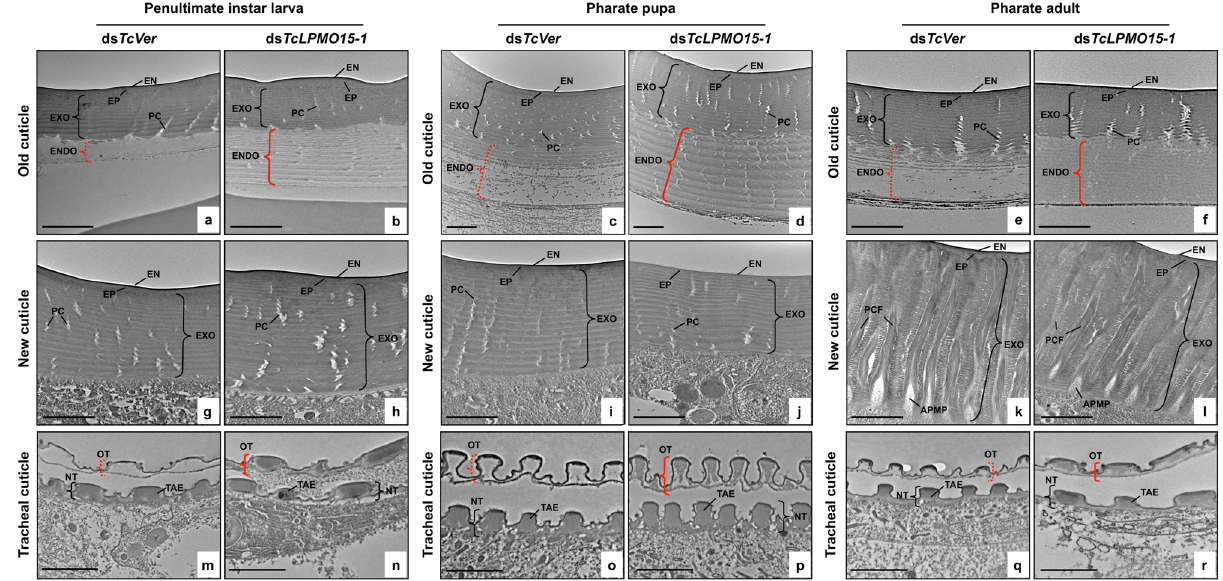
Fig. 5 Ultrastructure of cuticles from Tc LPMO15-1-de fi cient larvae, pharate pupae, and pharate adults of T. castaneum . Ultrastructure of old ( a – f ), newly forming cuticles ( g – l ), and tracheal cuticle ( m – r ) from penultimate instar larvae, pharate pupae, and pharate adults that had been injected with ds TcLPMO15-1 or ds TcVer at early instar, penultimate, and last instar larval stages, respectively, was analyzed by TEM. ds TcVer -treated controls showed degradation of the endocuticle (ENDO) in the overlying old cuticle (red dotted brackets) during each molt analyzed, while those of Tc LPMO15-1-de fi cient insects were intact, retaining a number of chitinous horizontal laminae (red solid brackets). Similarly, ds TcVer -treated controls exhibited degradation of the old tracheal cuticle (red dotted brackets), while the old tracheal cuticle of Tc LPMO15-1-de fi cient insects was incompletely degraded and contained electron-dense materials (red solid brackets). EN, envelope; EP, epicuticle; EXO, exocuticle; ENDO, endocuticle; PC, pore canal; PCF, pore canal fi ber; APMP, apical plasma membrane protrusion. OT, old tracheal cuticle; NT, new tracheal cuticle; TAE, taenidia. Scale bar = 2 µ m.